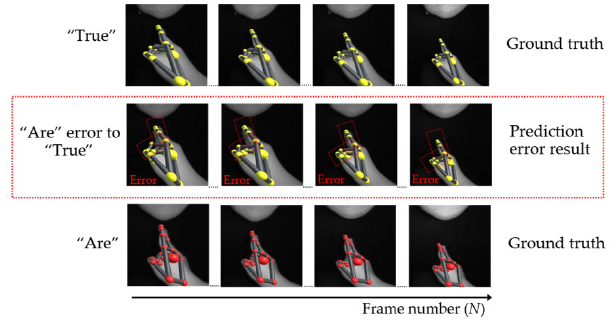
Figure 16. Example of an error caused by a finger.